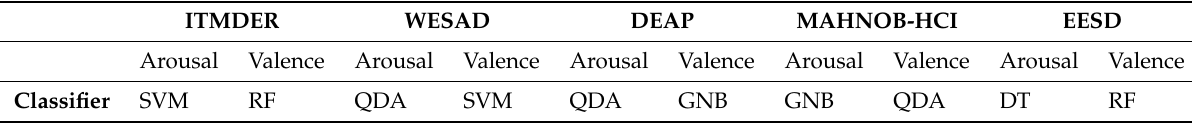
Table 7. Classifier used per dataset and sensor modality for the Arousal and Valence dimension in the FF methodology. Results obtained using 4-fold